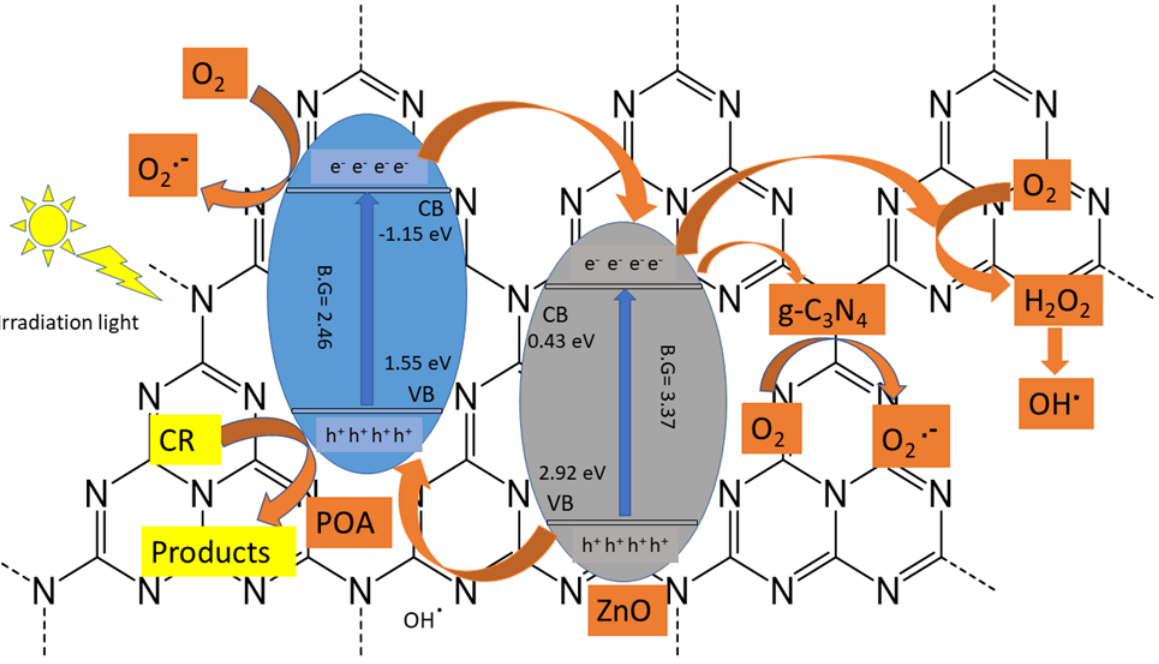
Figure 8. The suggested photo-reaction pathway of POA/g-C 3 N 4 /ZnO photo-catalyst composite for the CR dye degradation under UV light.